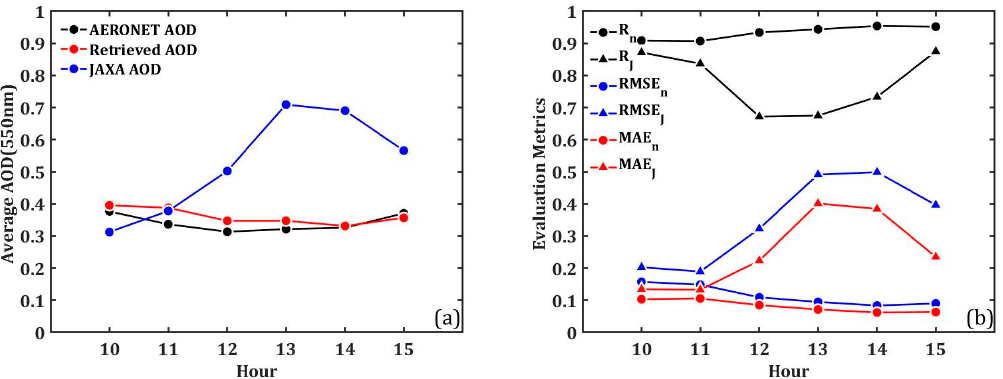
Figure 9. Diurnal variation of ( a ) AOD (550 nm) and ( b ) evaluation metrics. The subscript characters “n” and “J” denote the results for AOD-new and JAXA AOD, respectively.